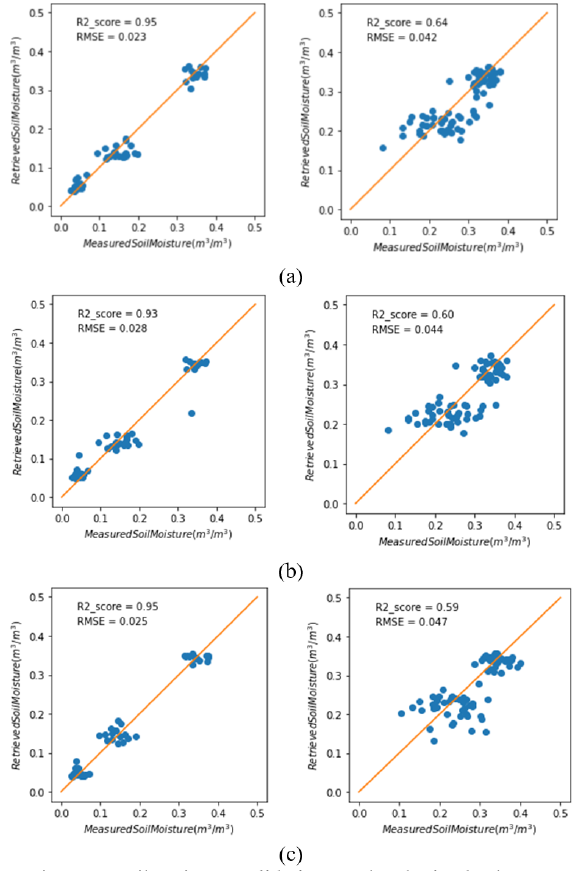
Figure 6. Results obtained using (a) GBRT, (b) XGB, and (c) RF regression models over canola (left column) and winter wheat (right column)